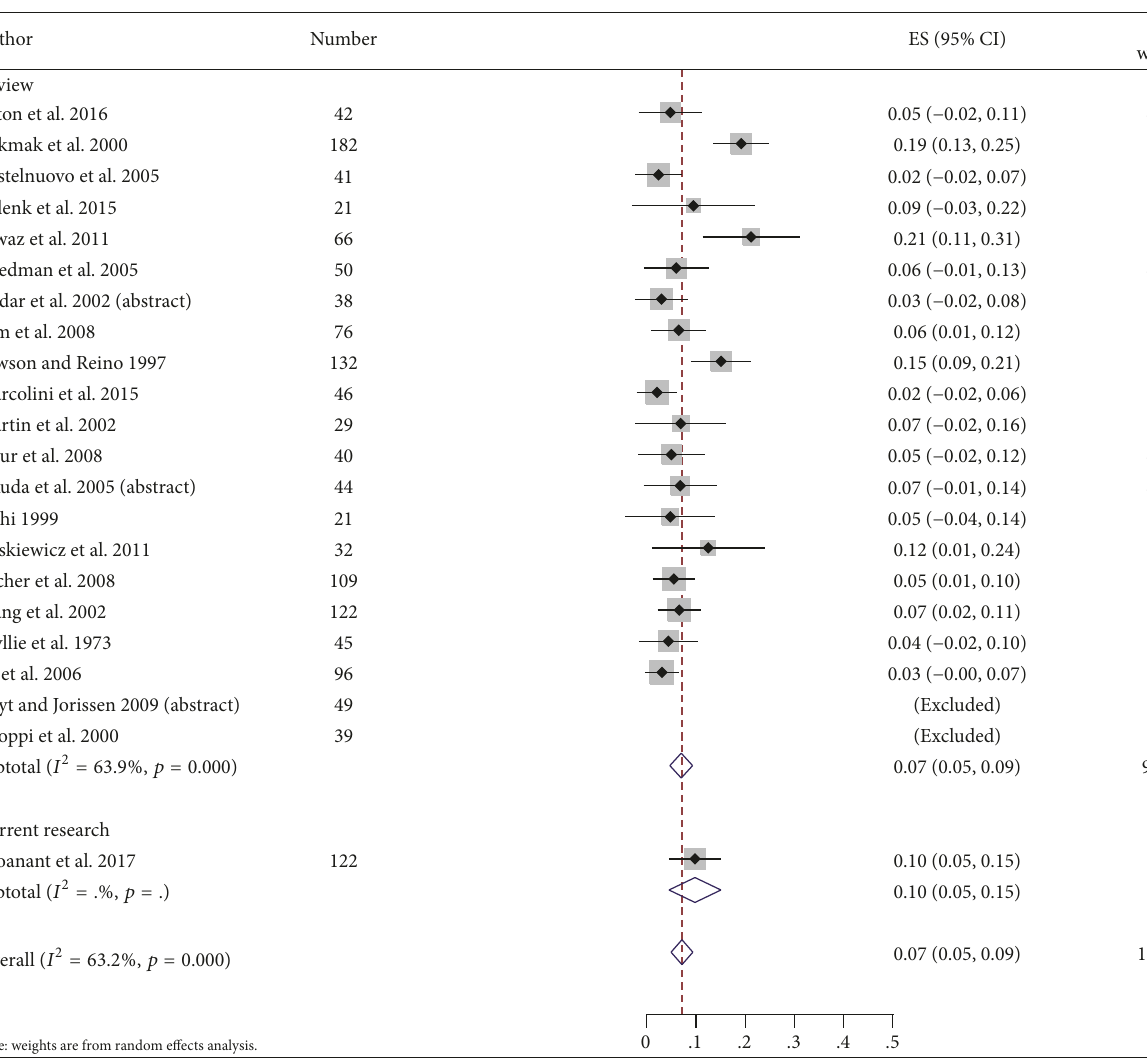
Figure 4: A forest plot shows the prevalence of malignant tumor among the sphenoid sinus